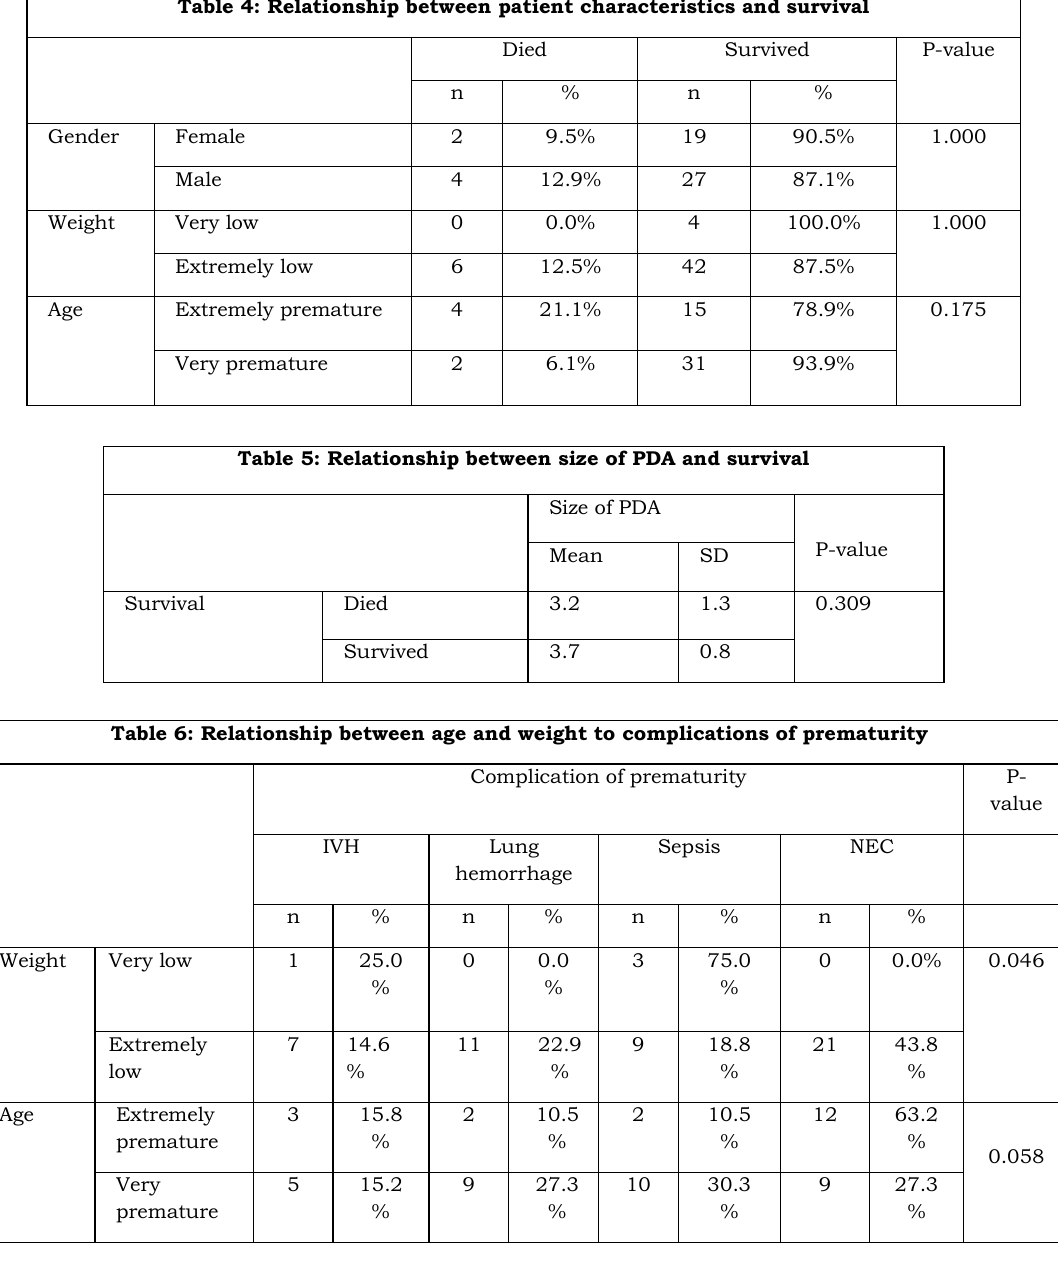
[Table 6]. Association between PDA size and